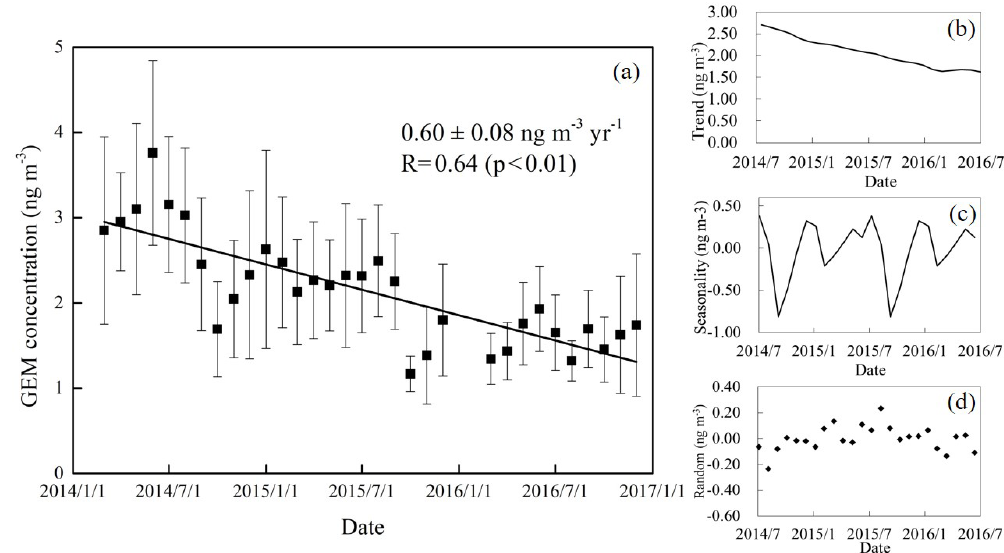
Figure 2. Monthly average GEM concentrations during the studied period: (a) observed monthly GEM concentrations, (b) GEM trend after decomposition, (c) GEM seasonality after decomposition, and (d) GEM random concentration after decomposition. Note that the observed concentrations during July 2015–April 2016 were TGM concentrations due to the problems of Tekran 1130/1135. However, the GOM concentrations at Chongming Island accounted for less than 1% of TGM. Thus, the GEM concentrations were approximated to TGM